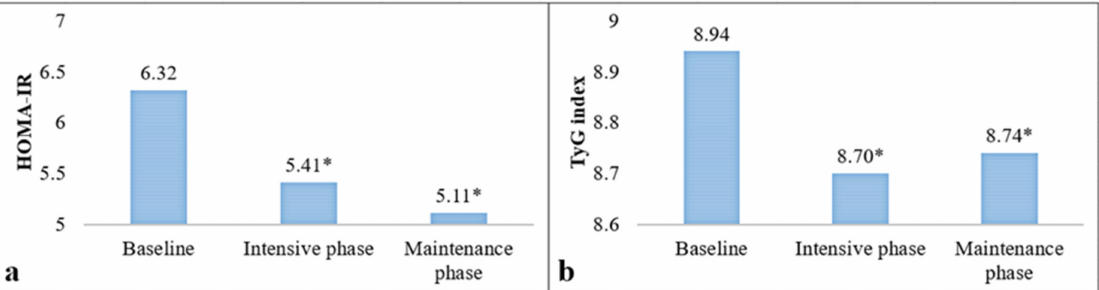
Figure 3. Comparison of HOMA-IR ( a ) and TyG index ( b ) levels in the intensive and maintenance phase of the PREVISY using protocol analysis (PA). HOMA-IR: Homeostasis Model Assessment of Insulin Resistance; TyG index: Triglycerides–Glucose Index. Expressed as the mean; *: Significant differences with respect to the baseline measurement ( p ≤ 0.05). Paired t -test.